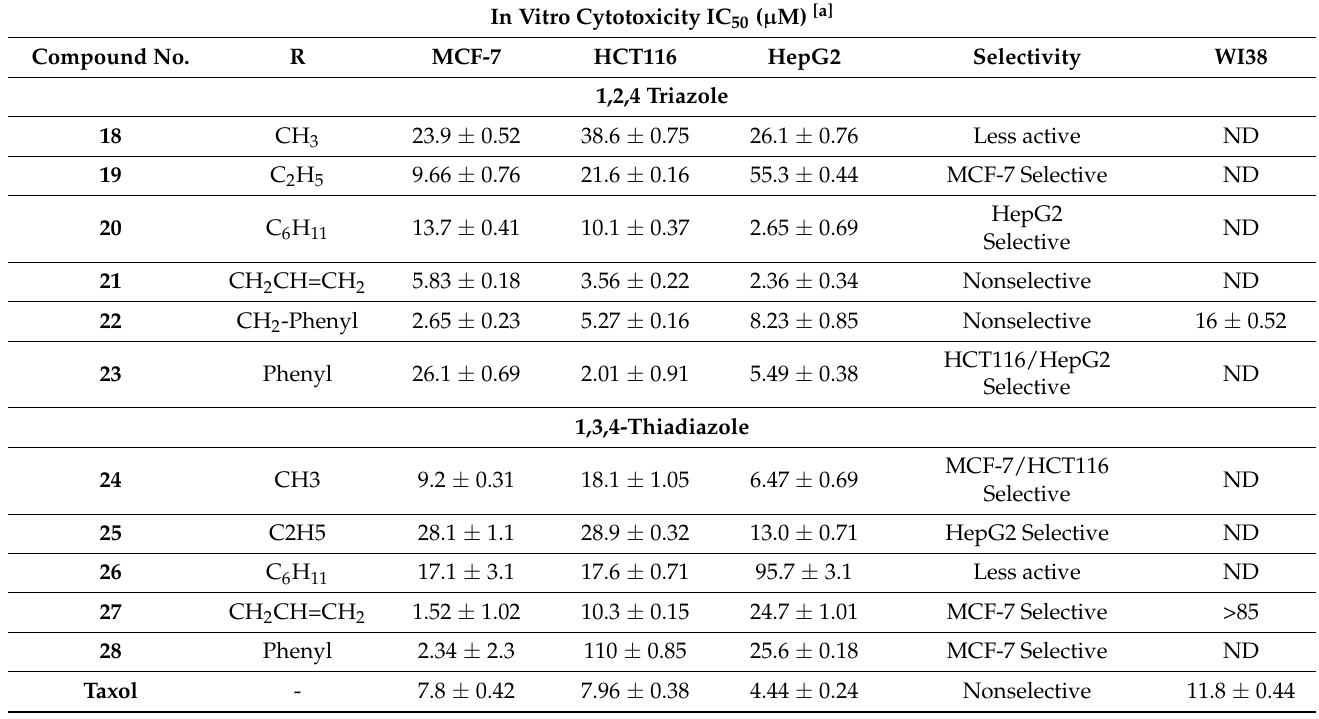
Table 1. MTT Cytotoxicity data of target compounds 18 – 28